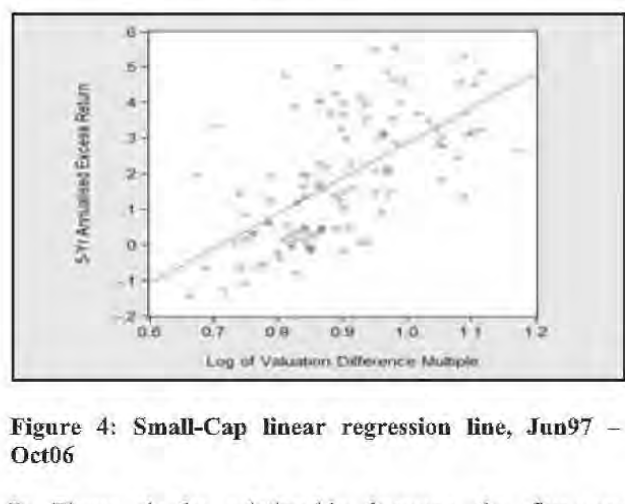
Figure 4: Small-Cap linear regression line, Jun97 - Oct06